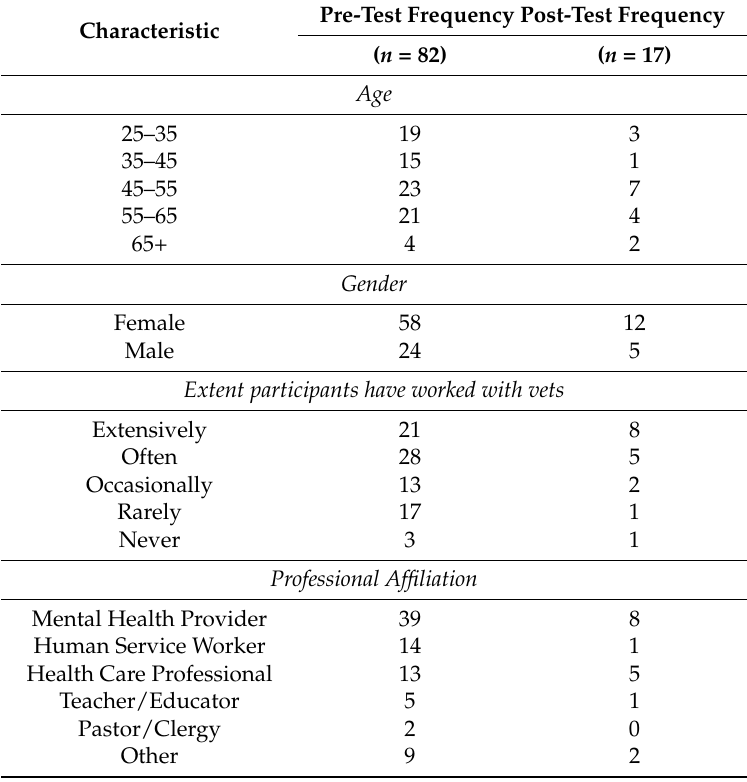
Table 1. Participant